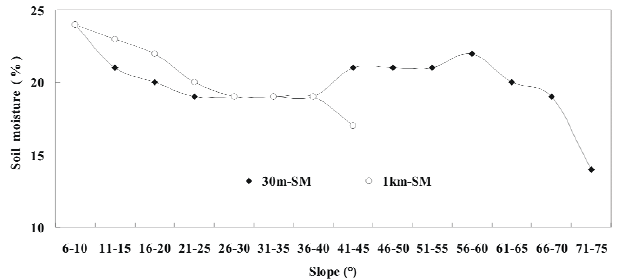
Fig. 16. Variations of the average soil moisture in the rooting zone with slope during the growing season at 30m and 1km